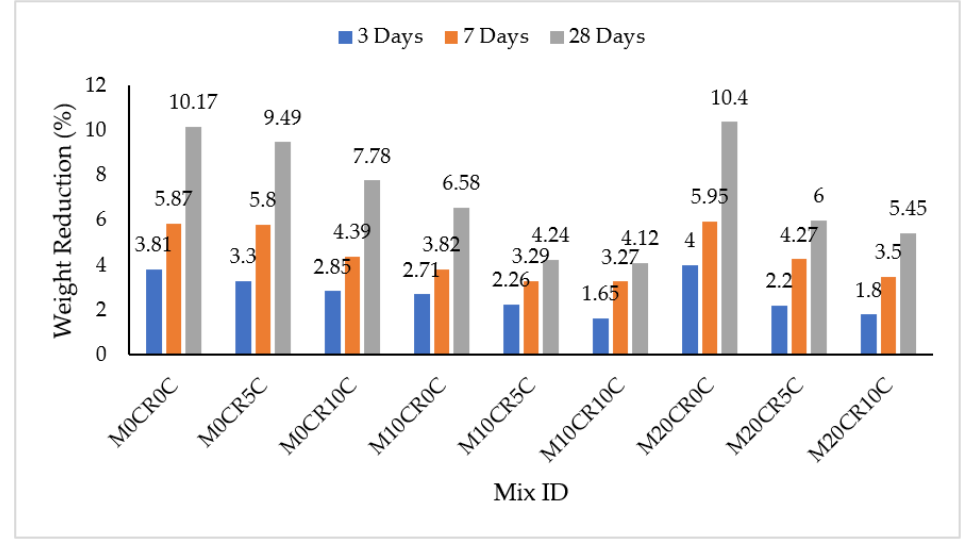
Figure 2. Immersion periods in H 2 SO 4 for SCC mixes containing CR and CCW.